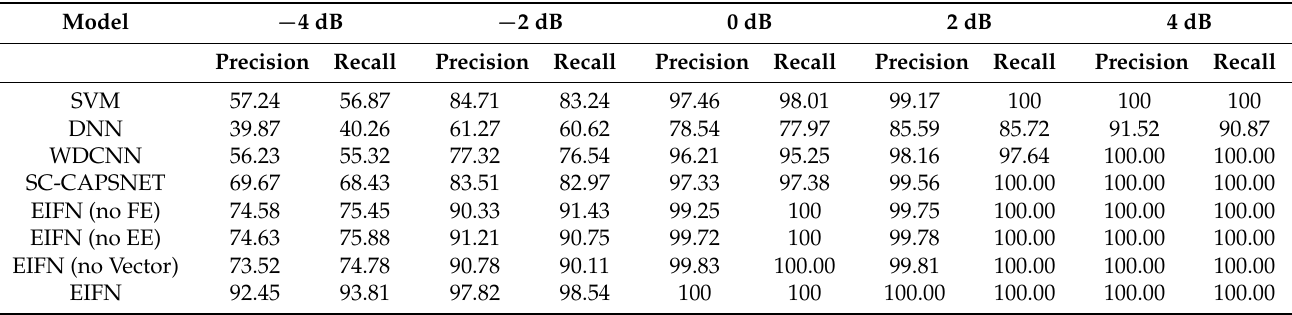
Table 6. Fault diagnosis results on